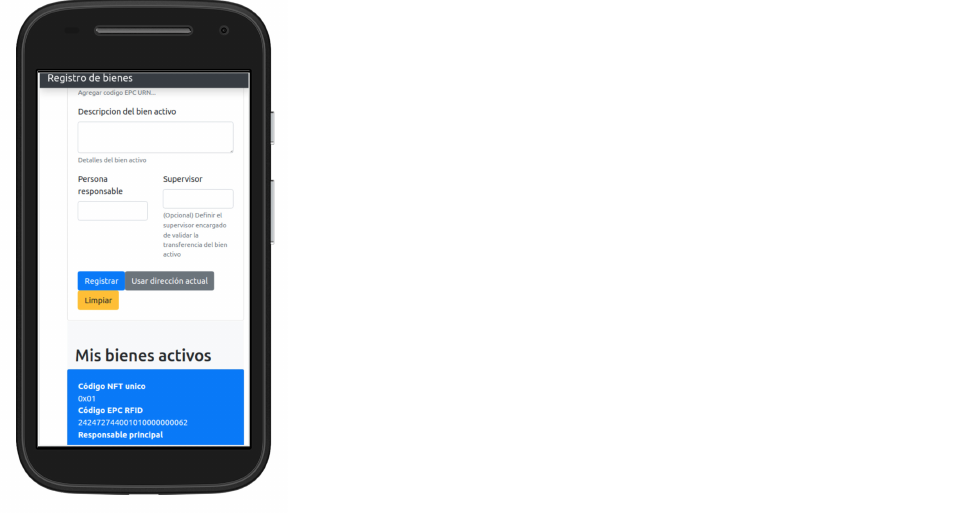
Figure 12. Chainway C72 RFID UHF GEN II portable reader, mobile DAPP showing the form to register new assets and the list of assets currently assigned in Spanish